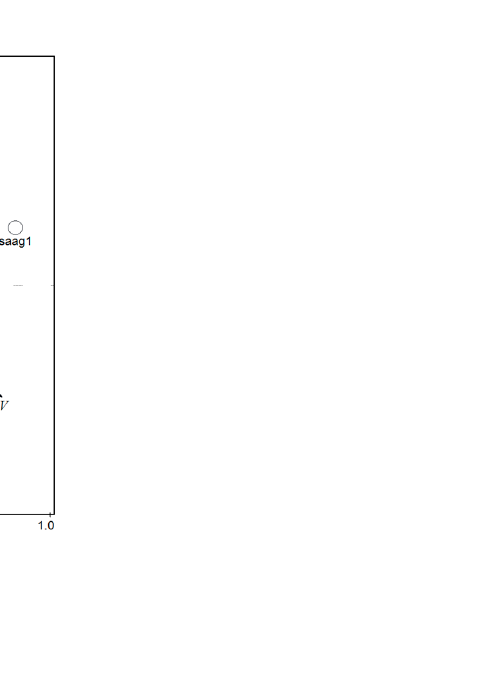
Figure 4. Principal component analysis (PCA) of two indices for the copper content and parameters. Table 4. Summary of the Cu results in